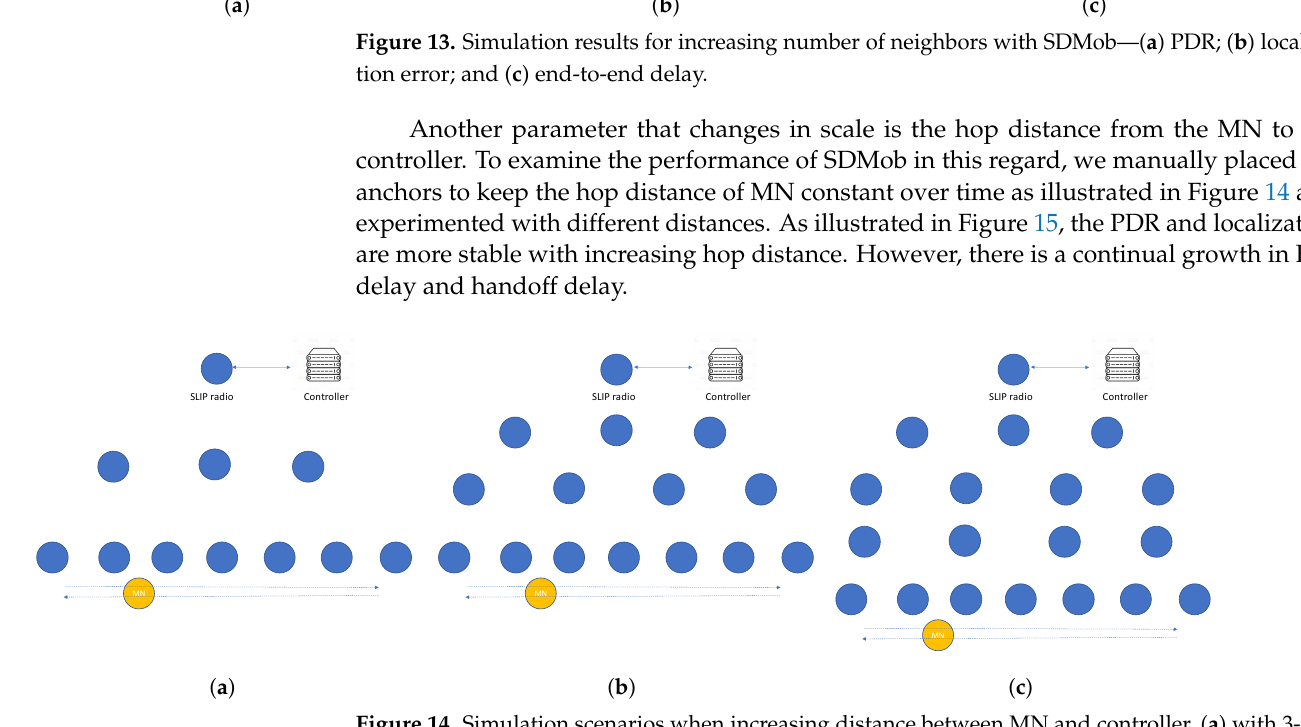
Figure 14. Simulation scenarios when increasing distance between MN and controller, ( a ) with 3-hop distance, ( b ) with 4-hop distance, and ( c ) with 5-hop distance.